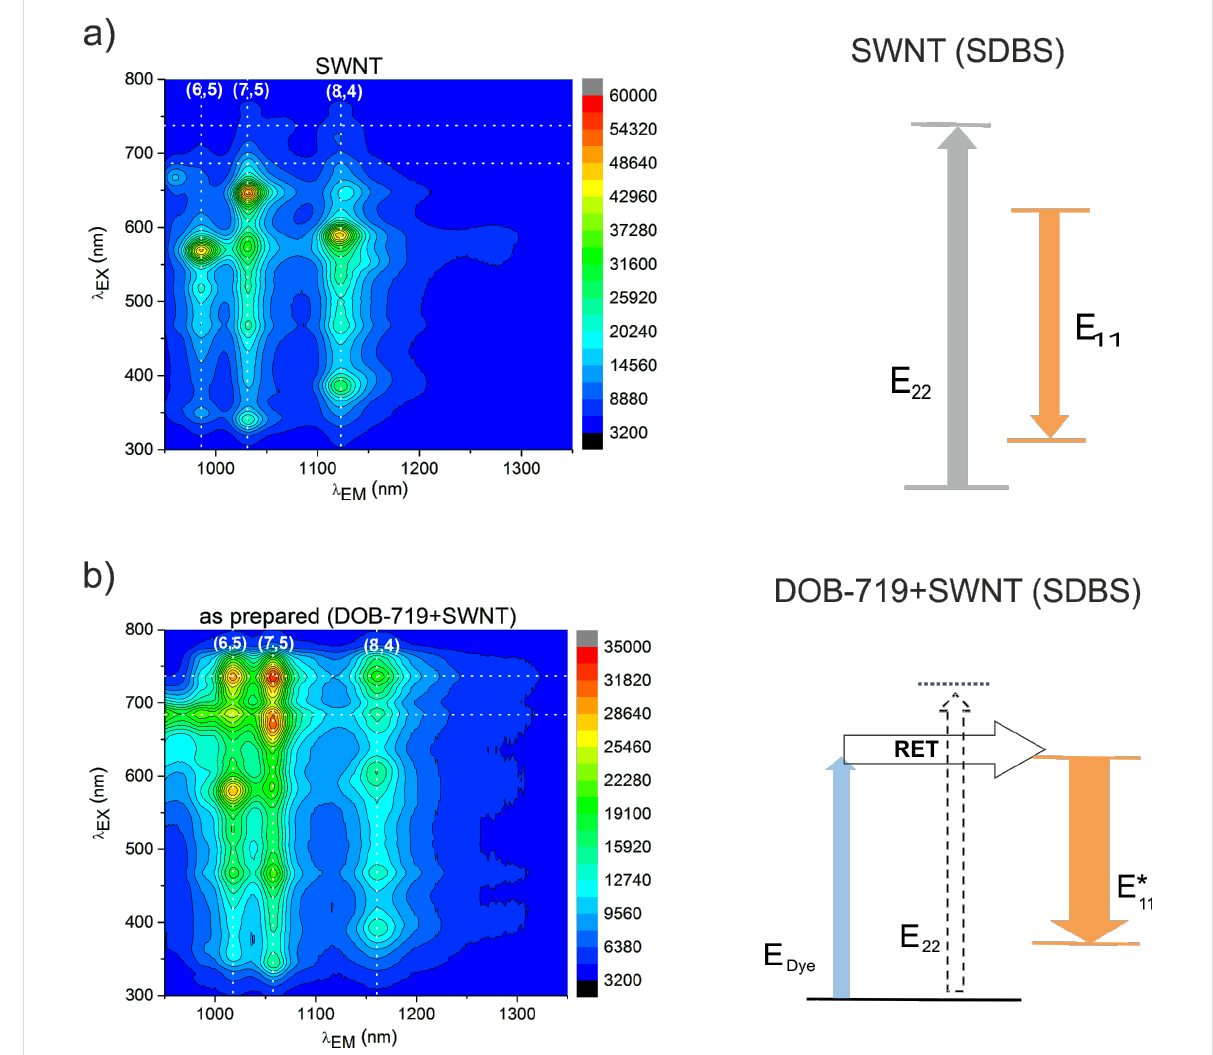
Figure 2: PLE maps (left) and the energy diagrams (right) for (a) dispersion of neat SWNTs and (b) as-prepared mixture of DOB-719 with the SWNT in water. Vertical dashed lines indicate λ EM positions of E 11 for SWNT of (6,5), (7,5), and (8,4) chirality, horizontal dashed lines indicate the position of new PL peaks at λ EX = 735 nm (the RET from DOB-719 to the SWNT) and the position of DOB-719 monomers maximum at λ EX = 685 nm. High PL intensities are coded in red colour, whereas low intensities are coded in blue colour. The concentration of DOB-719 in panel (b) is 0.001 mg/mL.